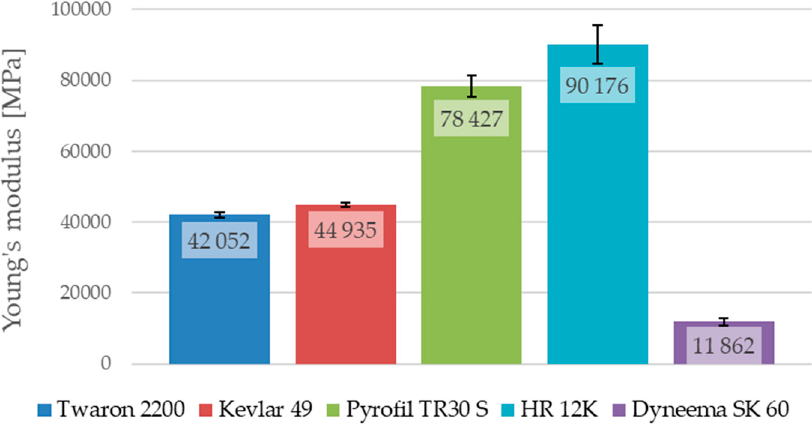
Figure 12. Average Young’s modulus of the epoxy composites with various reinforcing materials.